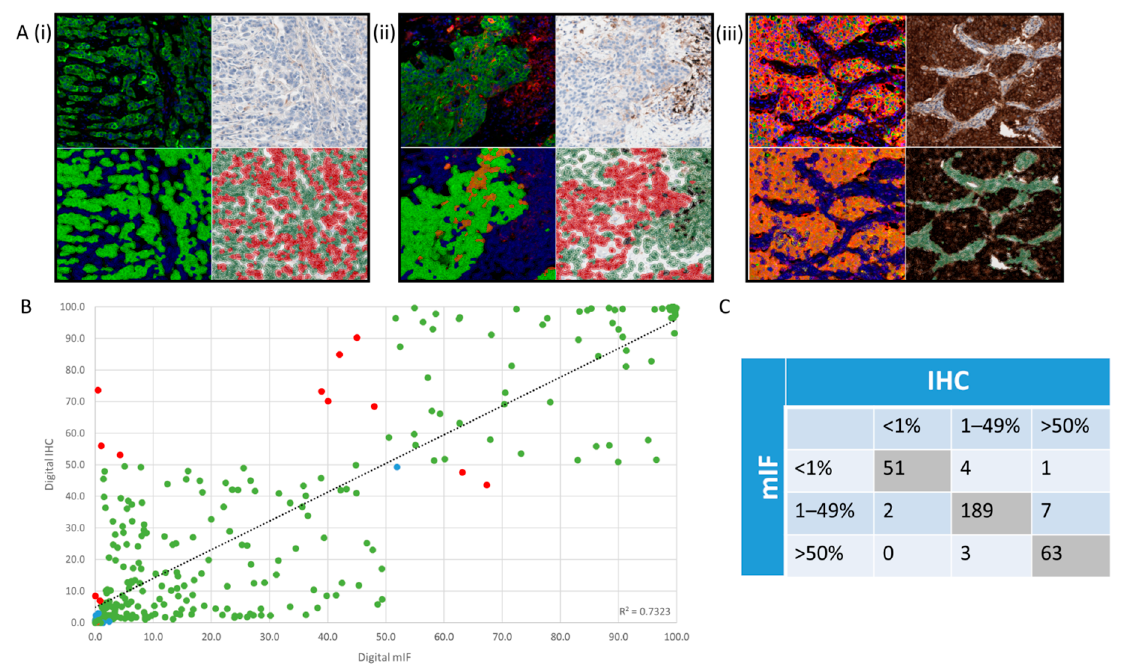
Figure 4. PD-L1 concordance between mIF and DAB IHC. Clinical categories, <1%, 1–49%, or >50%, are shown by representative mIF images ( A ) ( i – iii ), respectively. Each panel shows mIF image (top left), including the DIA mask (bottom left) and a DAB image (top right), including the DIA mask (bottom right). ( B ) shows DIA percentage positivity on 320 mIF TMA cores compared to DIA percentage positivity of the corresponding DAB IHC slides (R 2 = 0.7323). Green data points display concordance, red display discordance, and blue demonstrate cases where the ground truth is difficult to discern upon review. ( C ) displays the raw categorical data displaying the graph in ( B ).